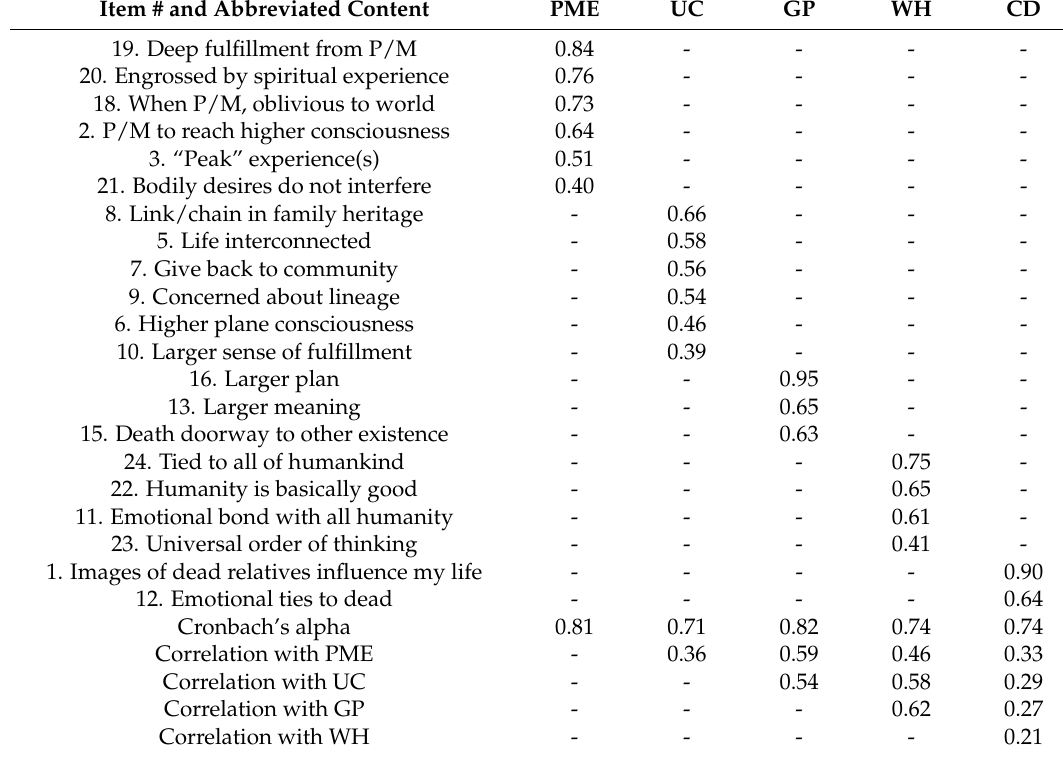
Table 1. Five-Factor Model from Exploratory Factor